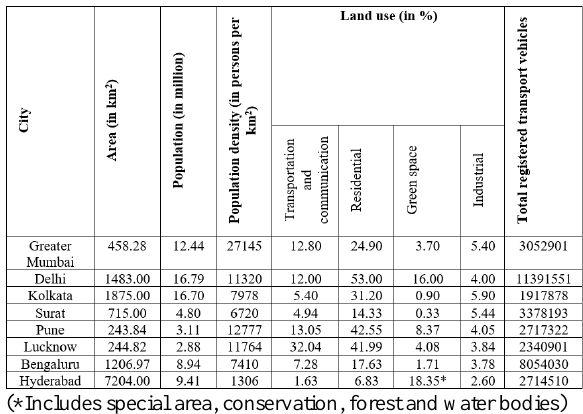
Table 1. City wise anthropogenic factors responsible for pollution